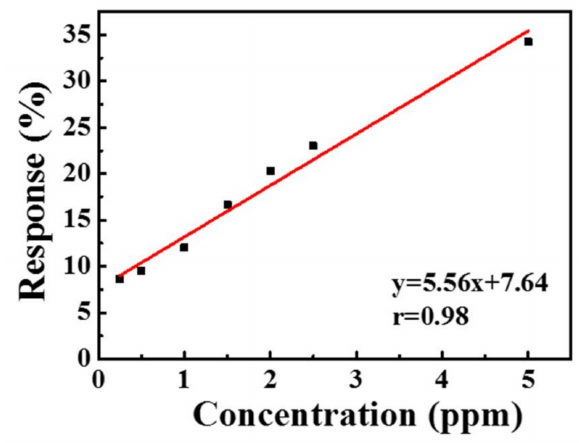
Figure 9. The response value of the sensor to different concentrations of NO 2 at 150 ◦ C.